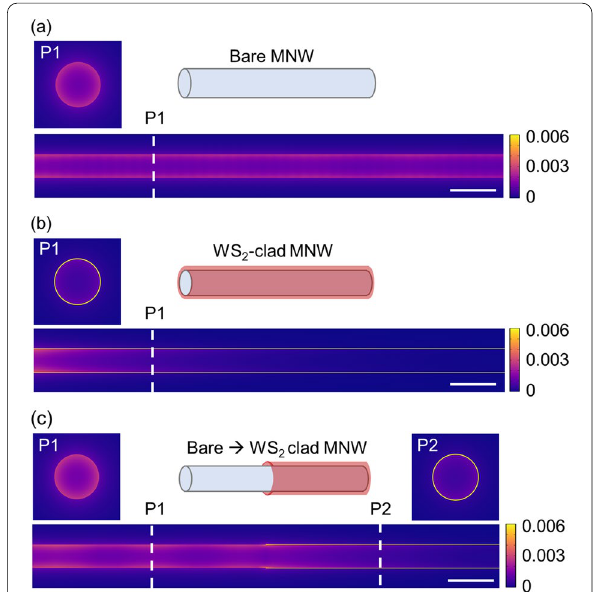
Fig. 7 Energy density distributions at the transverse cross section plane and along the propagation direction of a a bare MNW without cladding, b a WS 2 -clad MNW, and c coupling from a bare MNW to a WS 2 -clad MNW at the excitonic resonance based on 3D simulations. For better visualization, energy densities are normalized and plotted in a color bar with saturation (for more information, see Additional file 1: Fig. S12). P1 and P2 represent the transverse cross section planes located at the positions indicated by the white dashed lines. Scale bars (right bottom white lines): 100